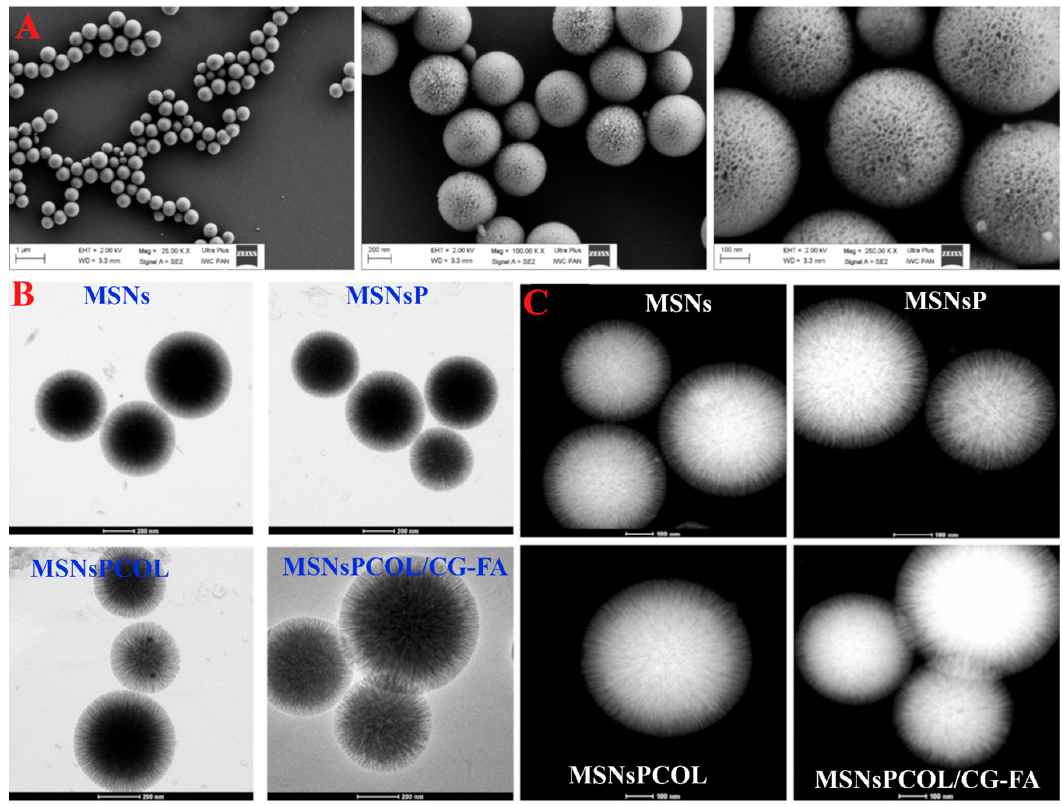
Figure 2. Morphological structures of the materials. ( A ) Field emission scanning electron microscopy